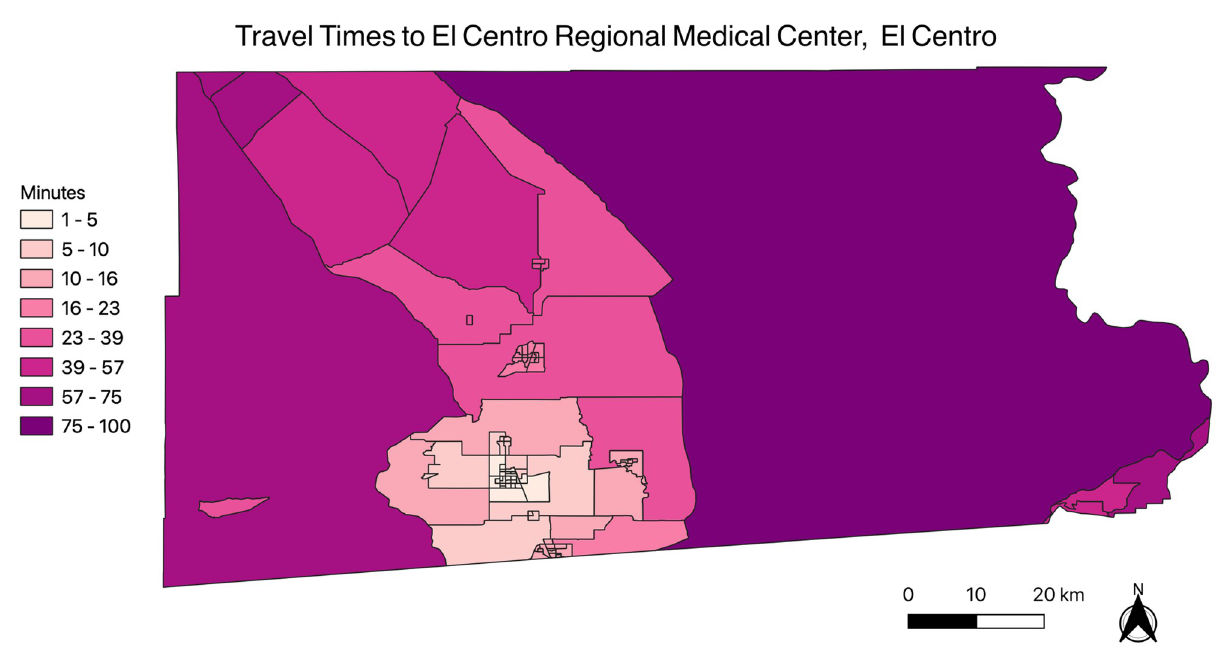
Fig 2. Travel times between census tract centroids and El Centro Regional Medical Center, El Centro. The map was generated using the free and open-source software QGIS version 3.14 (http://www.qgis.org/en/site/about/index.html).